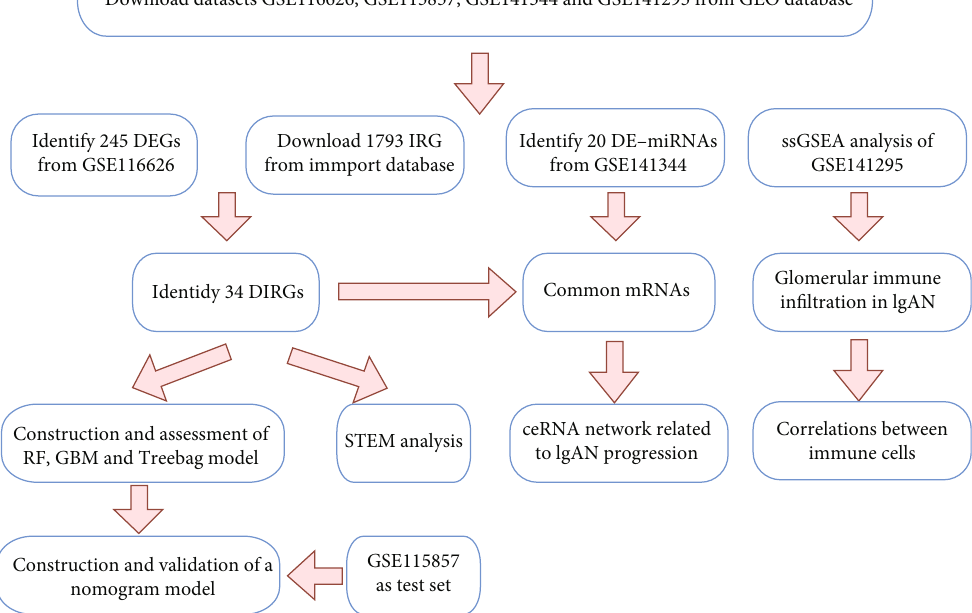
Figure 1: Work fl ow of the research. Abbreviations are de fi ned as follows: Gene Expression Omnibus database (GEO), di ff erentially expressed gene (DEG), immune-related gene (IRG), di ff erent immune-related gene (DIRG), di ff erentially expressed miRNA (DE- miRNA), random forest (RF), Gradient Boosting Machine (GBM), Short Time-Series Expression Miner